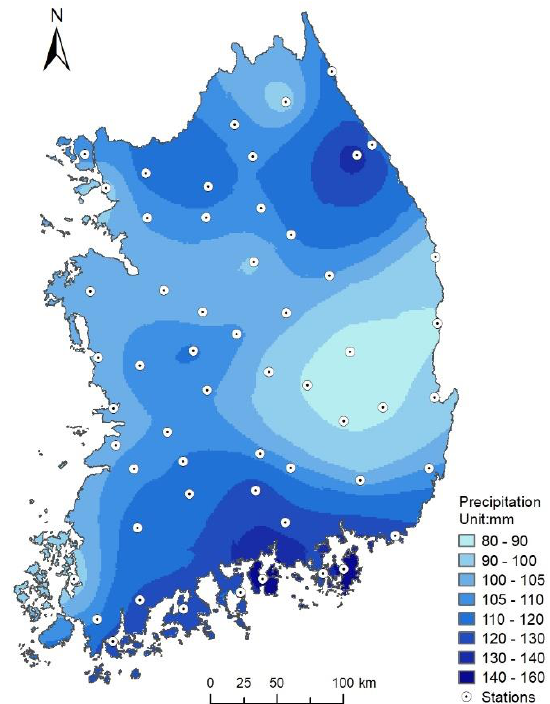
Figure 3. Spatial distribution of mean monthly precipitation data totals from 1973–2021 in South Korea.